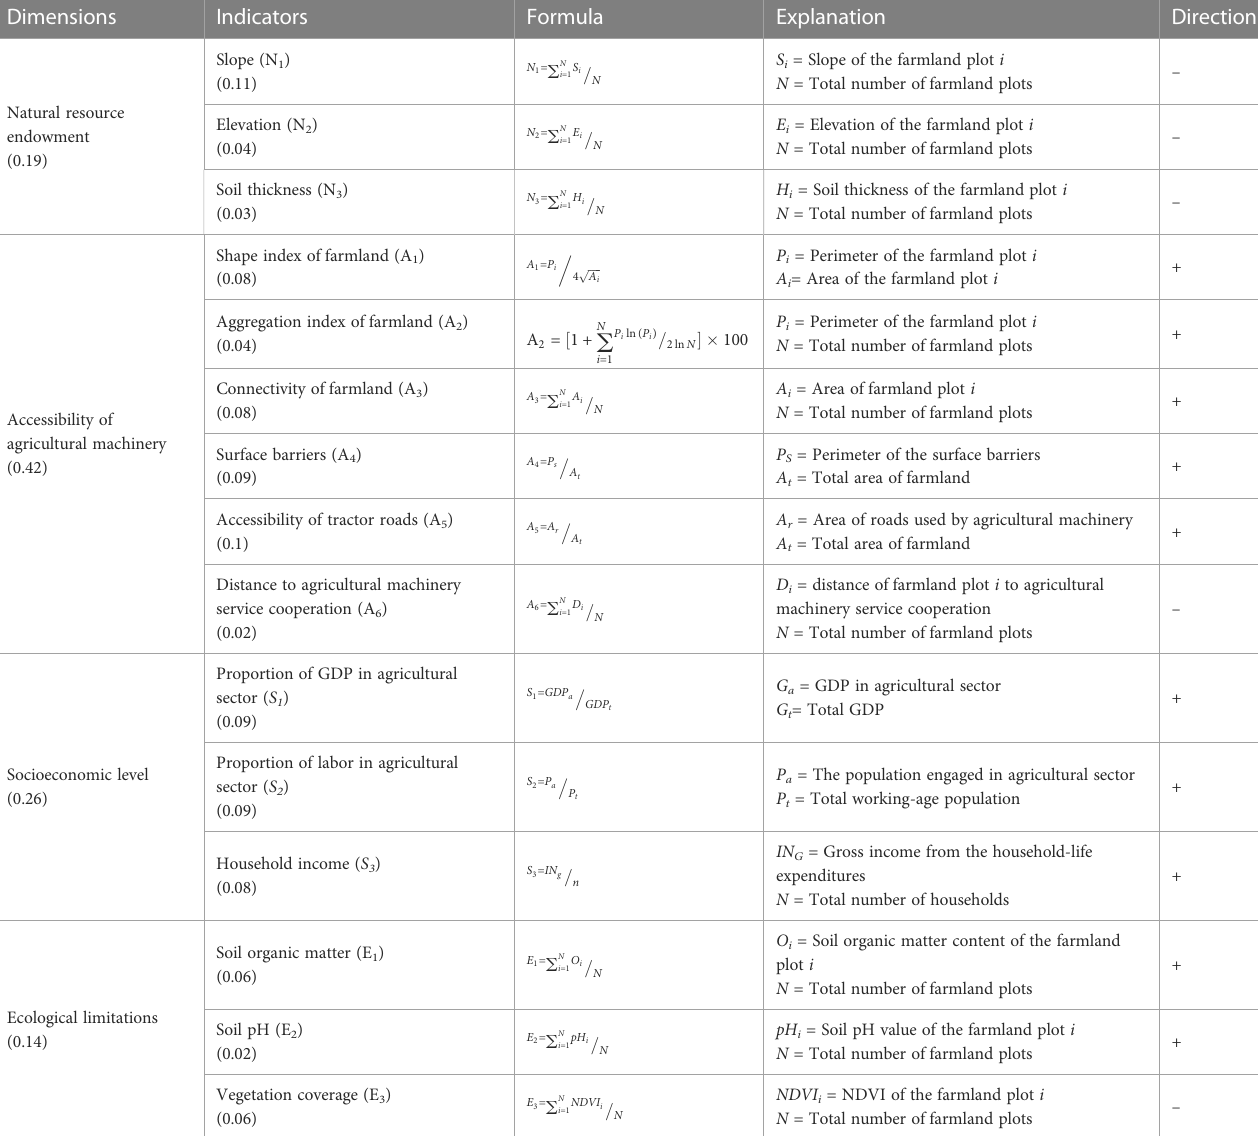
TABLE 1 Description of the indicators assessing the suitability of FCAM. Dimensions Indicators Formula Explanation Direction